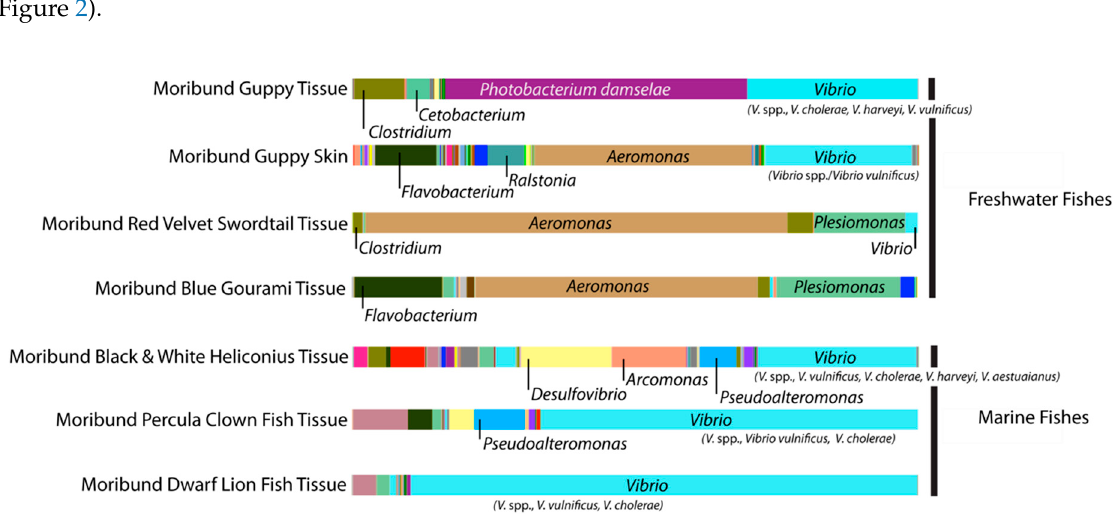
Figure 2. Bar graphs of bacterial Operational Taxonomic Units (OTUs) at the genus level based on V6–V4 rRNA gene amplicon sequencing from moribund freshwater and marine fish microbiomes from a Massachusetts pet shop. Marine species displayed larger relative abundances of Vibrio genera, while freshwater species showed dominance by Photobacterium or Aeromonas . All three genera include species potentially pathogenic to fishes. The V6–V4 hypervariable region cannot differentiate between certain species of vibrios, hence some of the vibrios are designated spp.